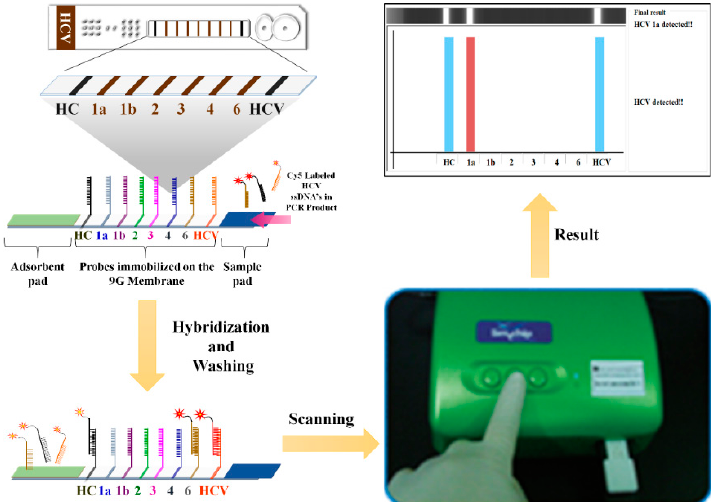
Figure 19. Schematic representation of the working principle and the experimental protocol of 6 HCV Genotyping 9G Test (Reproduced with permission from [115]).